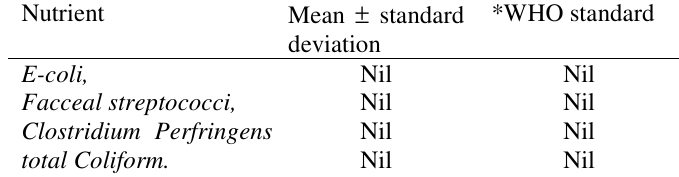
Table 4 . Bacteriological quality of the water Nutrient Mean –